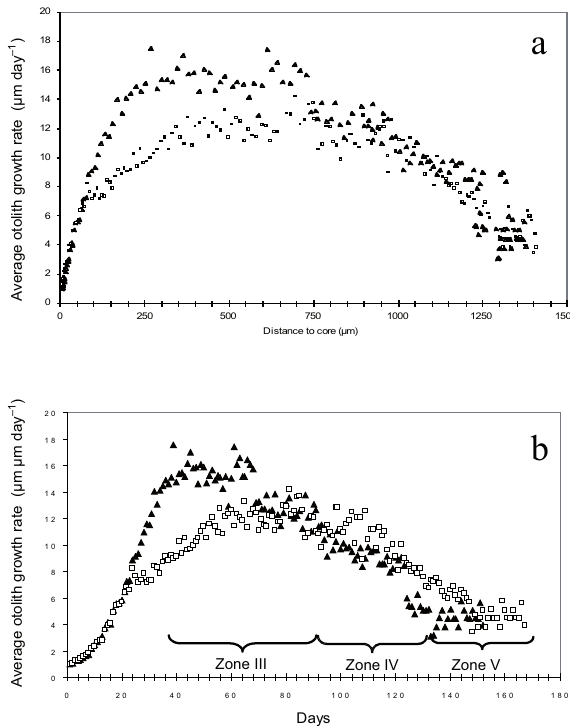
Fig . 4. – a) Average otolith growth rate of juvenile measured in the postrostrum axis from core. Group band method (triangles) and indi- vidual mark method (squares) n=22. b) Average otolith growth rate of juvenile measured in the postrostrum axis in days. Group band method (triangles) and individual mark method (squares) n=22.